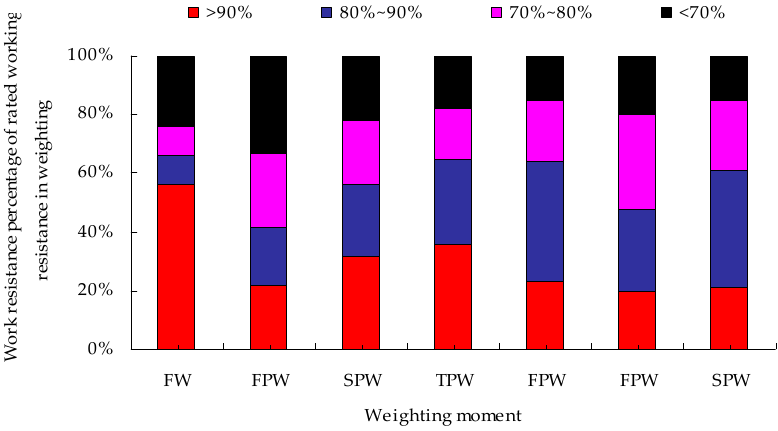
Figure 13. Supportability statistics of the support.